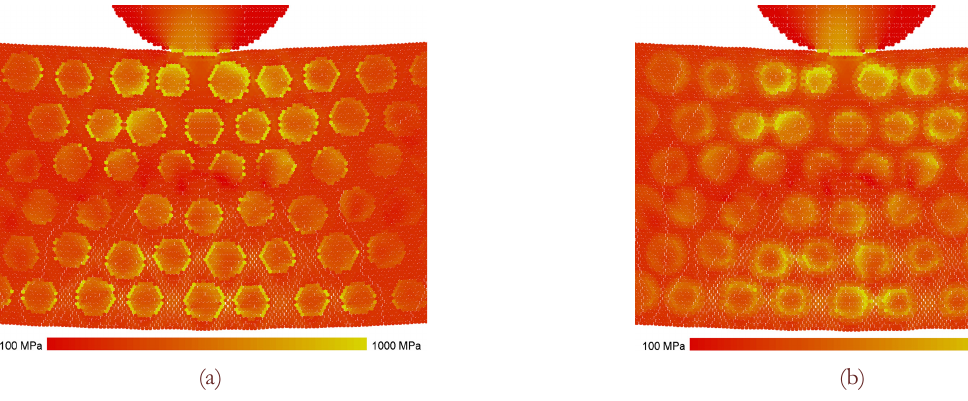
Figure 17: Stress intensity distribution in the central part of the samples of metal-ceramic composite with “narrow” (a) and “wide” (b) interphase boundaries. Three-point bending test. Stress distributions correspond to the bending angle  = 3.5